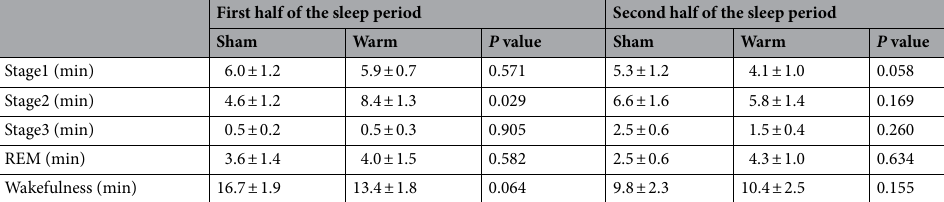
Table 3. EEG sleep parameters in first and second halves of the sleep period. All are values expressed as mean ± SEM of eighteen subjects. Comparisons were performed relative to the sham condition using the Wilcoxon signed rank test. REM, rapid eye